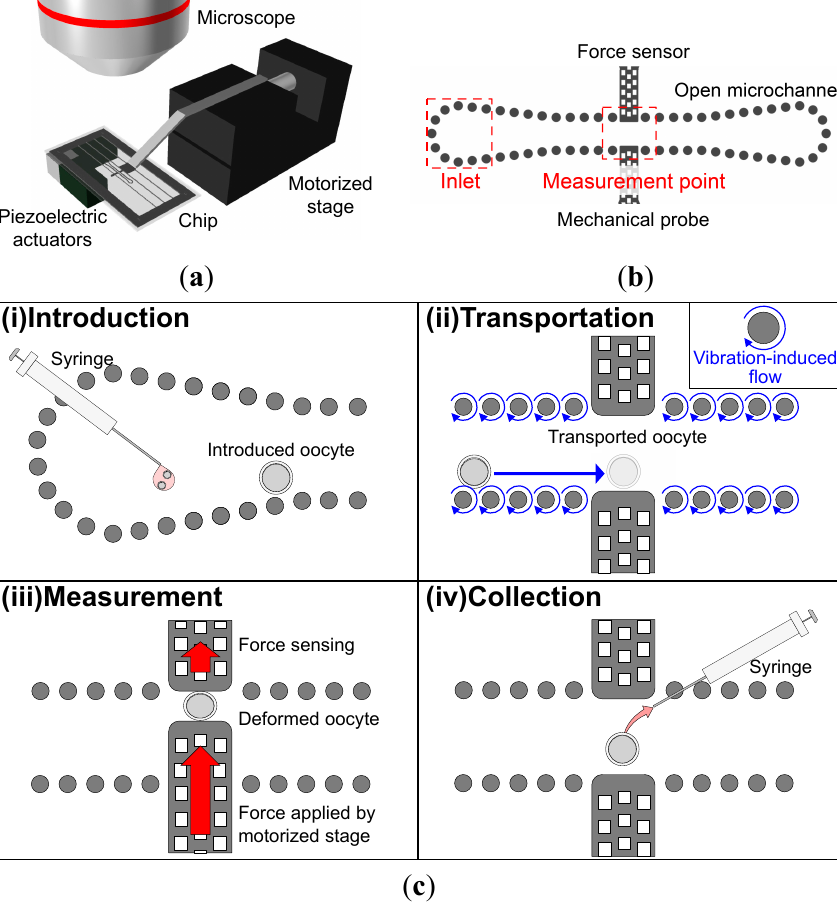
Figure 2. Concept of on-chip transportation and measurement of the mechanical characteristics of oocyte in an open-environment: ( a ) Schematic of the system setup; ( b ) schematic of the chip design; ( c ) procedure of proposed measurement